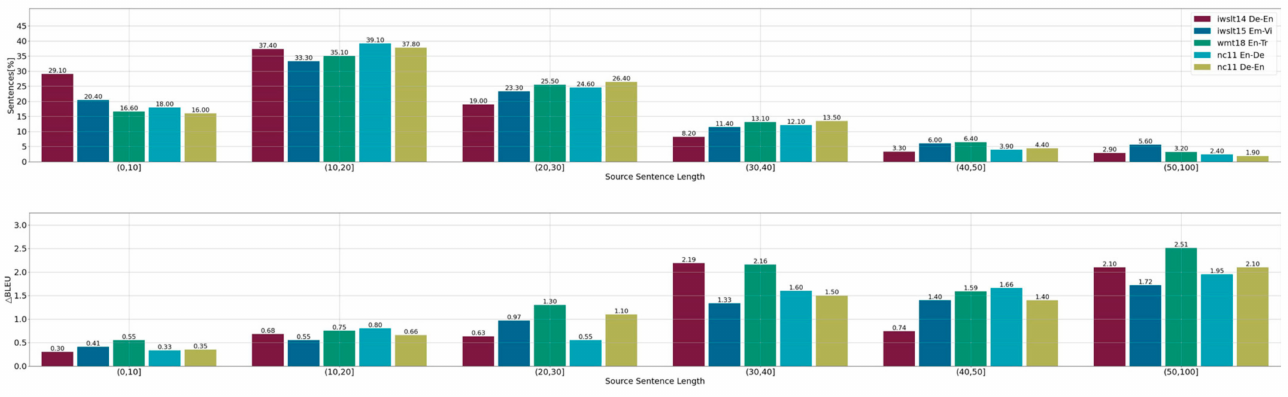
Figure 5. Percentage data ( above ) and ∆ BLEU scores ( below ) for the